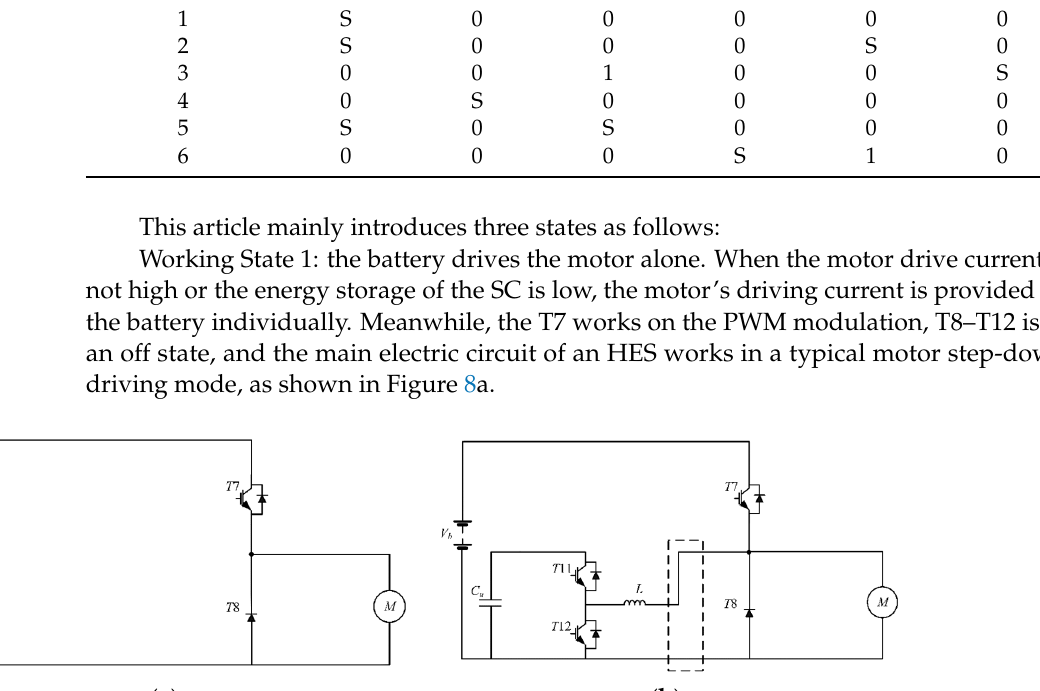
Table 2. The working state of the main electrical circuit.